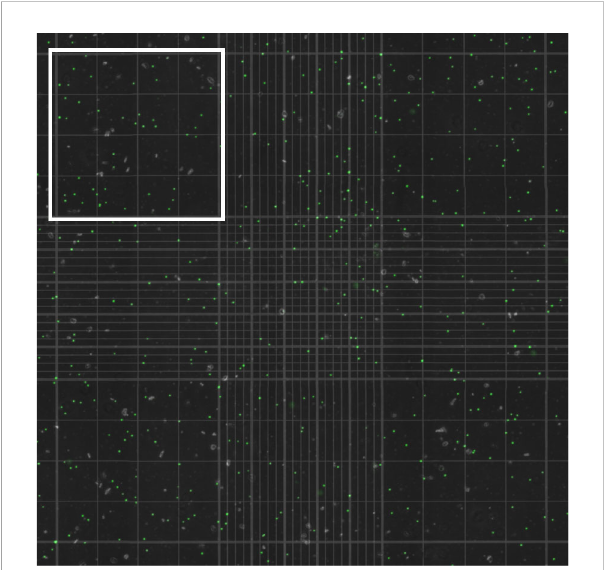
FIGURE 2 Algal cells extracted from an anemone and quanti fi ed using a hemocytometer visualized with an inverted fl uorescent microscope. Auto fl uorescent algal cells were counted in each of four (of nine) large grid squares on the hemocytometer, one of which is outlined in white, for each of three aliquots per anemone. Algal counts in the four grid squares were then averaged for each